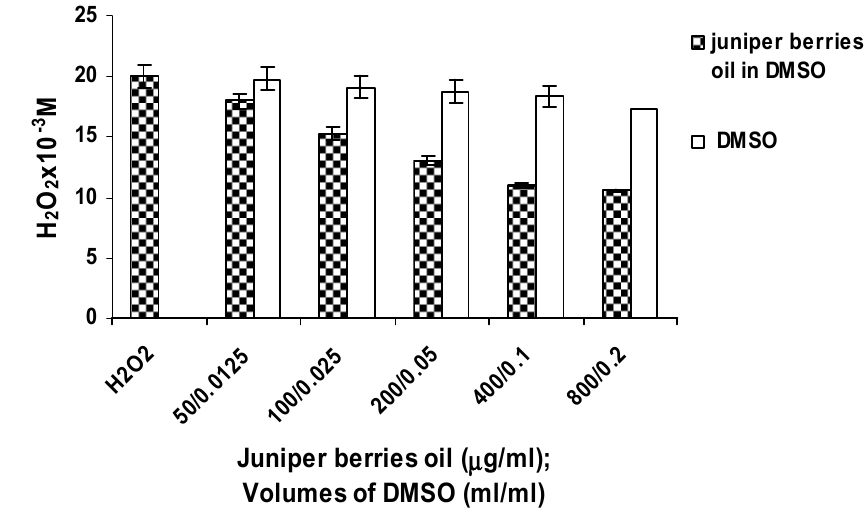
Figure 2. Hydrogen peroxide scavenging activity of juniper berry